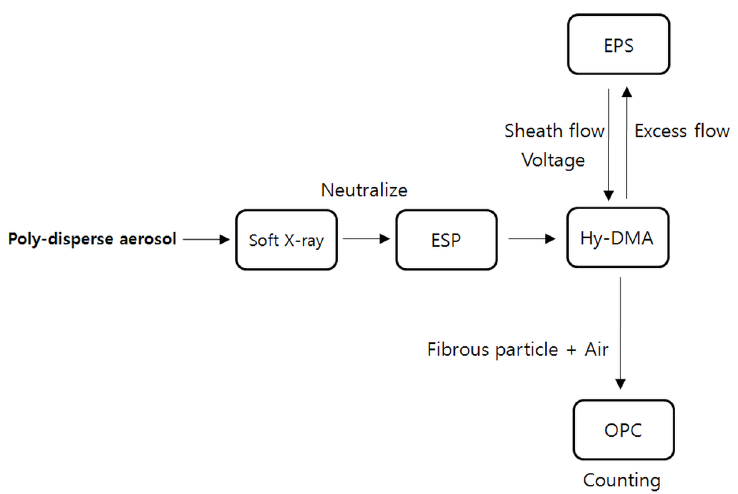
Fig 2. Flowchart of the components and processescomprising the